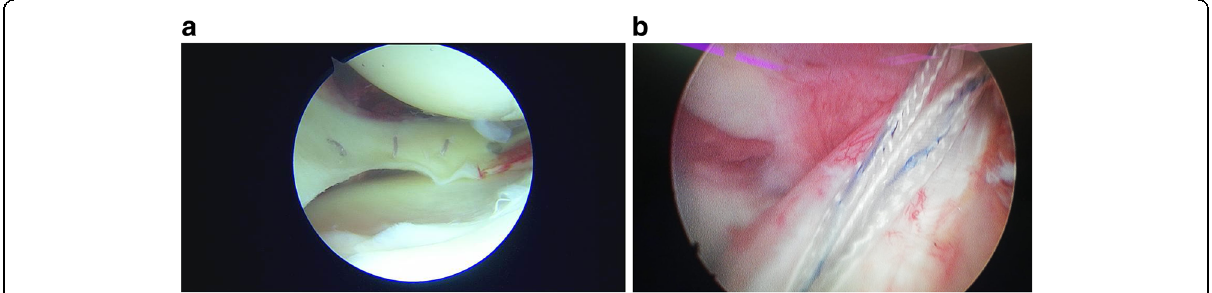
Fig. 7 a In-out meniscal repair. b ACL Repair and Internal